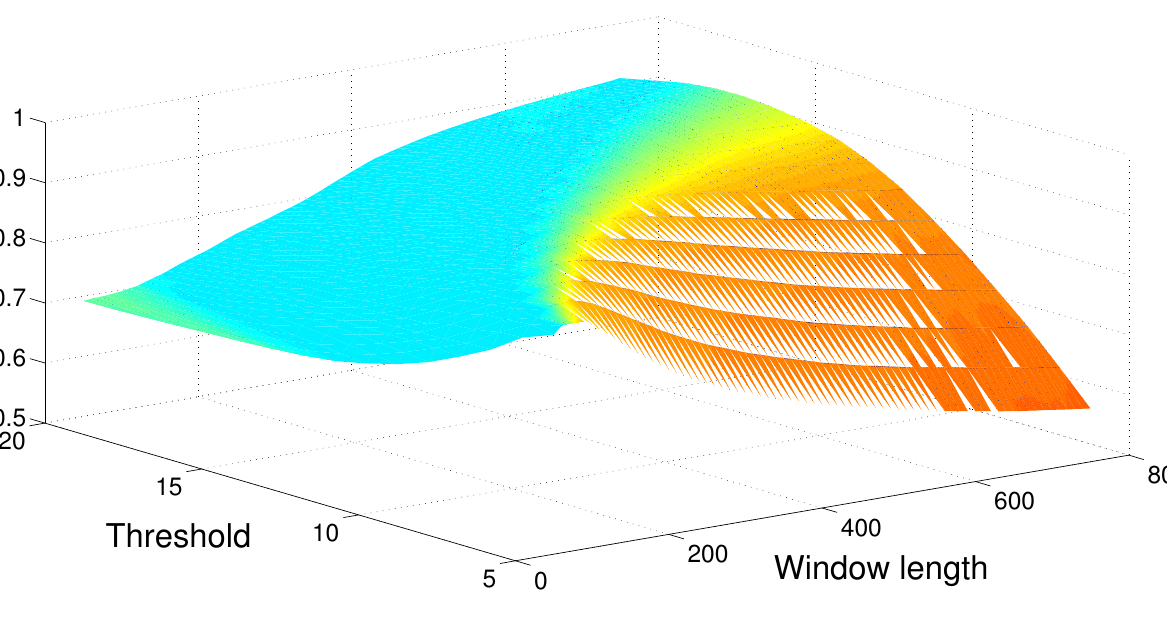
Figure 6. Parameter optimization. Sweep of window length and threshold values to find maximum accuracy (MBGTD). Real